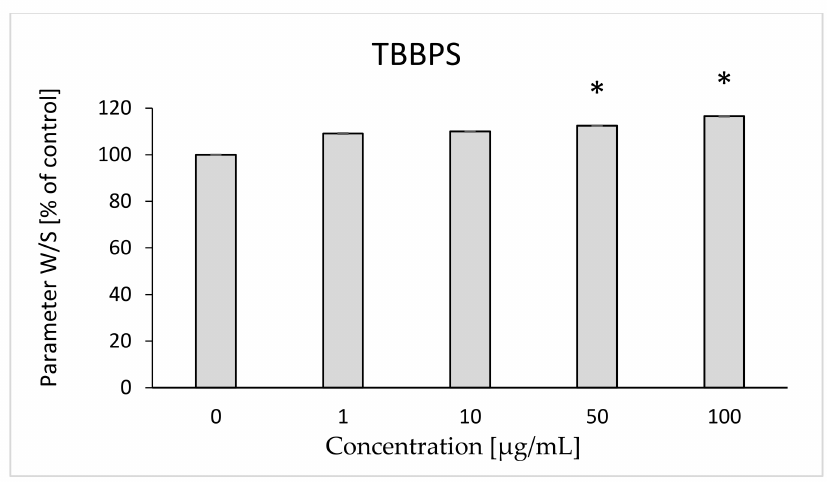
Figure 2. Changes in W/S in human control erythrocytes and the erythrocytes incubated with TBBPS at 1 to 100 µ g/mL for 48 h. (*) Significantly different from control ( p < 0.05).